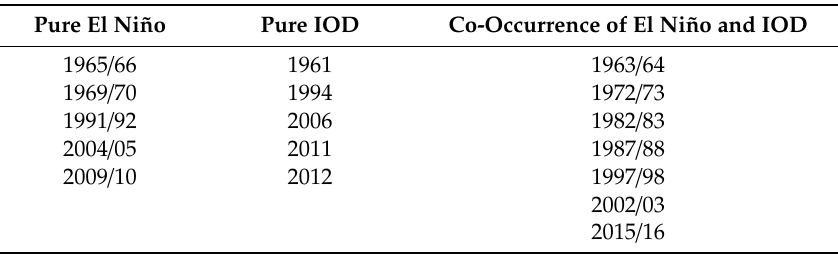
Table 1. List of composite years for pure El Niño, pure Indian Ocean Dipole (IOD), and the co-occurrence of the El Niño and